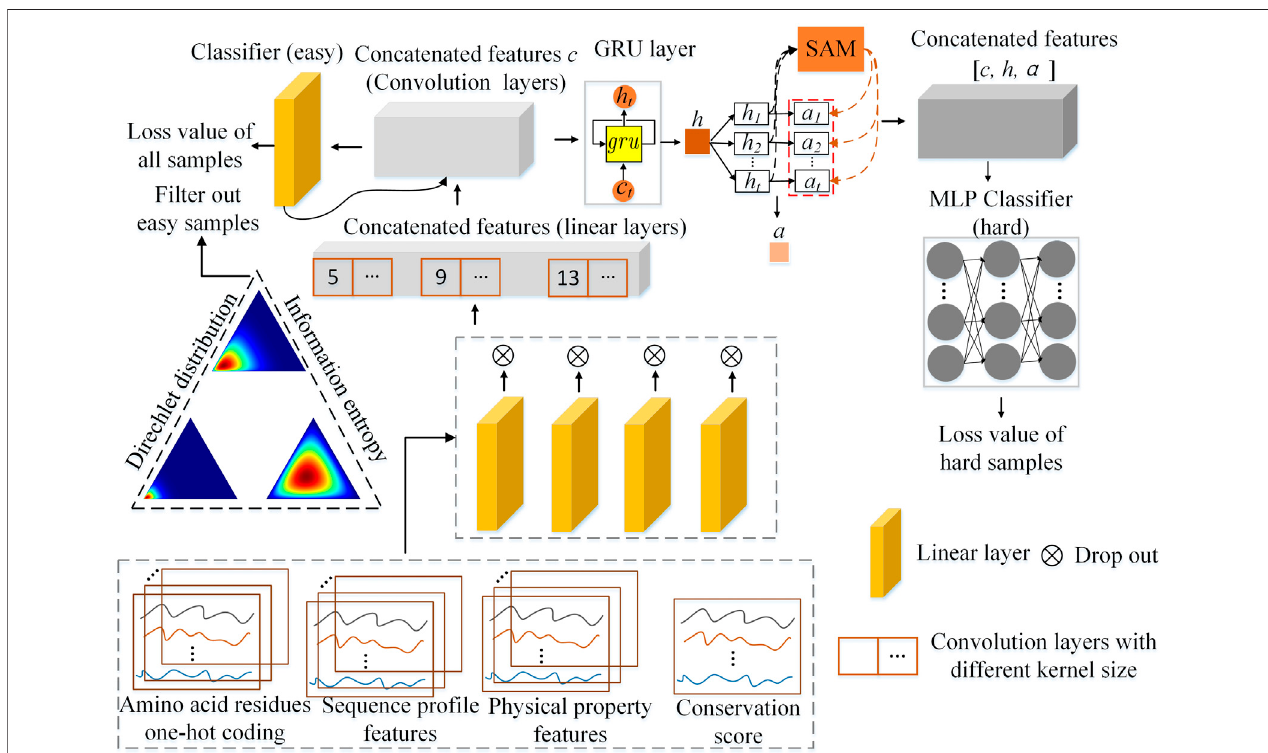
FIGURE2| The overallarchitectureofthe Multistage CombinationClassi fi erAugmentedModel (MCCM) forprotein secondary structureprediction ingenetics and bioinformatics.